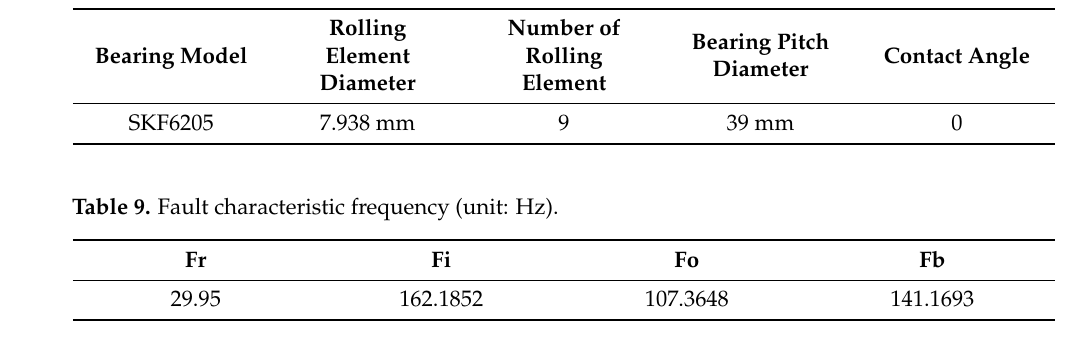
Figure 13. Bearing test rig. Table 8. The bearing structure factor of SKF 6205.